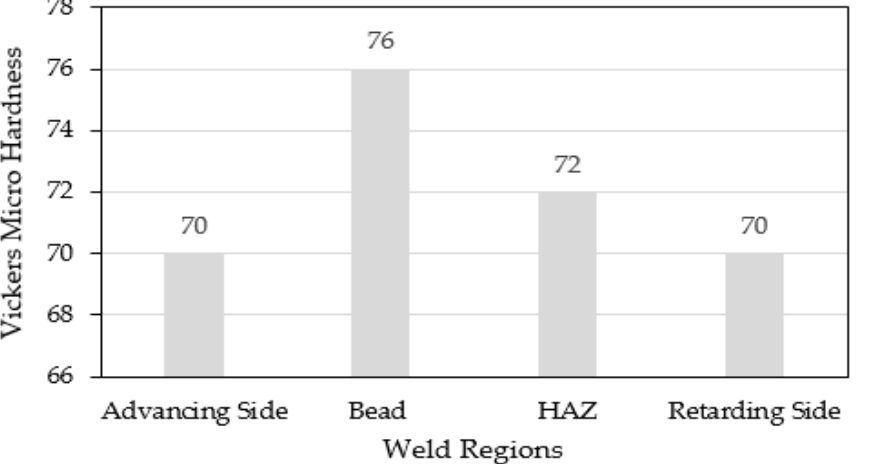
Figure 6. Vickers microhardness of the weld regions.